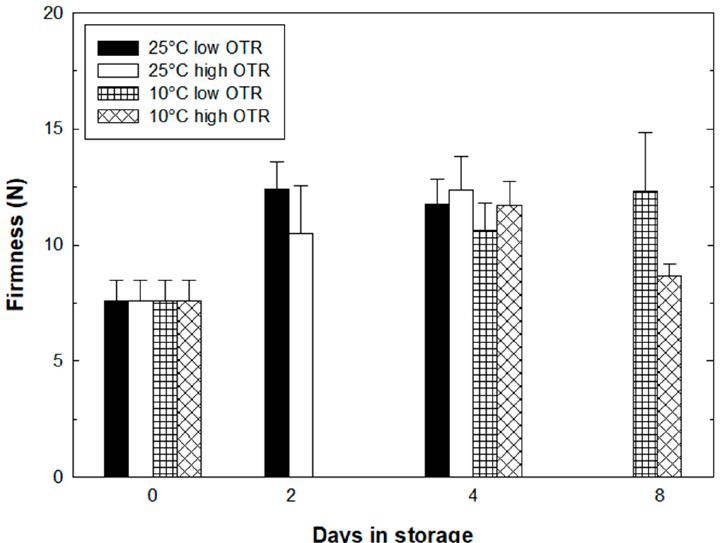
Figure 3. Firmness of ‘Pione’ grapes stored in passive MAP with low and high-OTR films at 25 °C for 4 days and 10 °C for 8 days. Vertical lines represent the standard error of the mean ( n = 9).